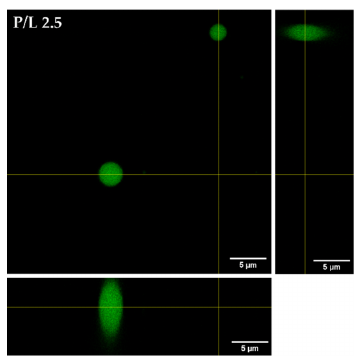
Figure 9. Formation of new lipid aggregates at higher W-BP100 concentration. Representative or- thogonal view of lipid agglomerates formed at a 2.5 P/L ratio. Magnification: 630×, zoom 0.5×. Scale bar: 5 µm. Membranes 2023 , 13 , 138 17 of 22